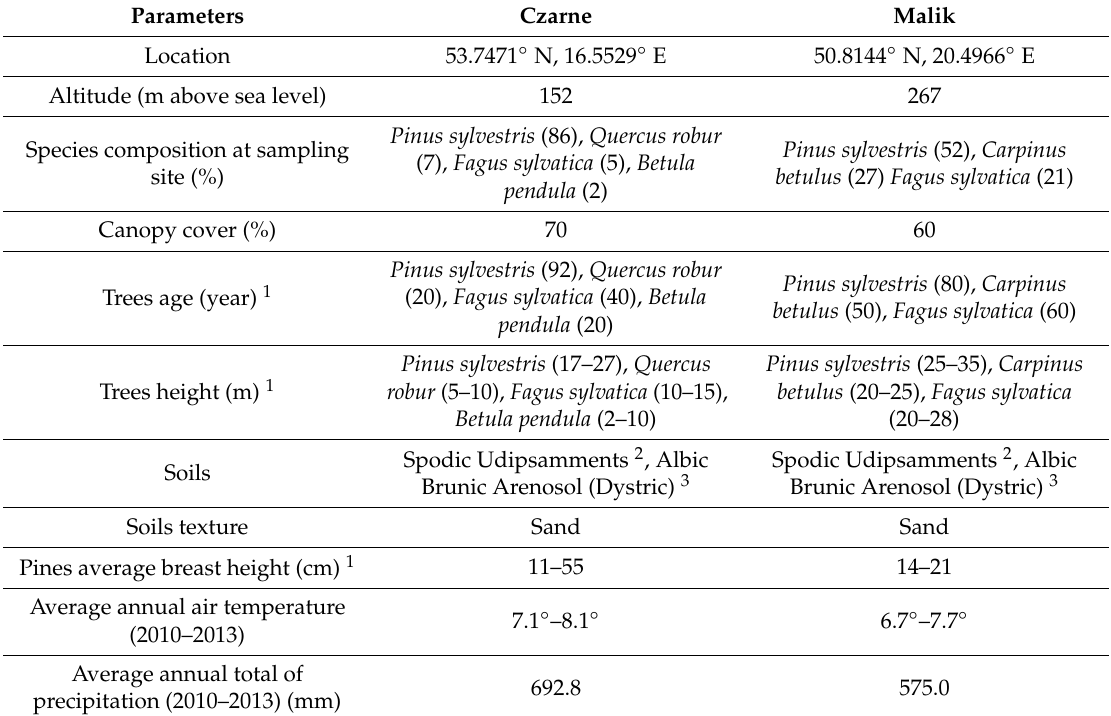
Table 1. Characteristics of the experimental stands.